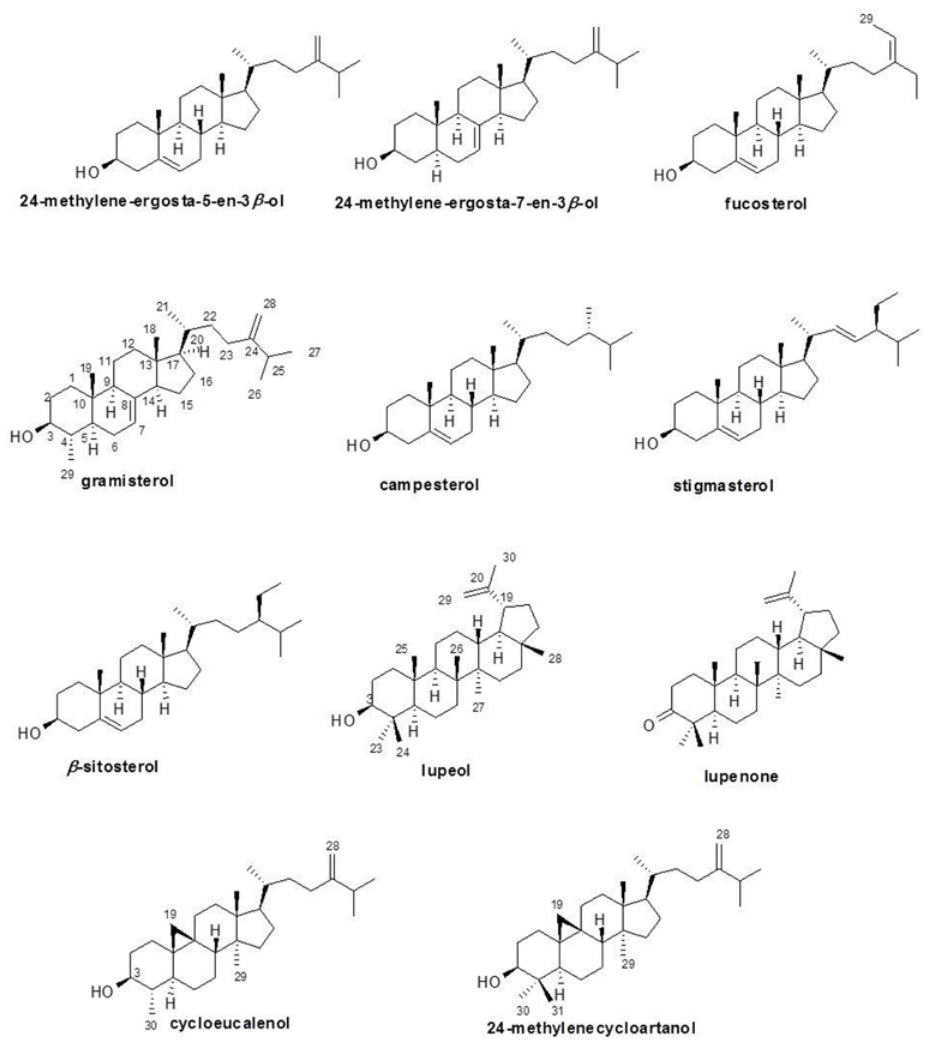
Figure 1. The structures of sterol and triterpenoid compounds obtained from the extract of black rice bran cv.